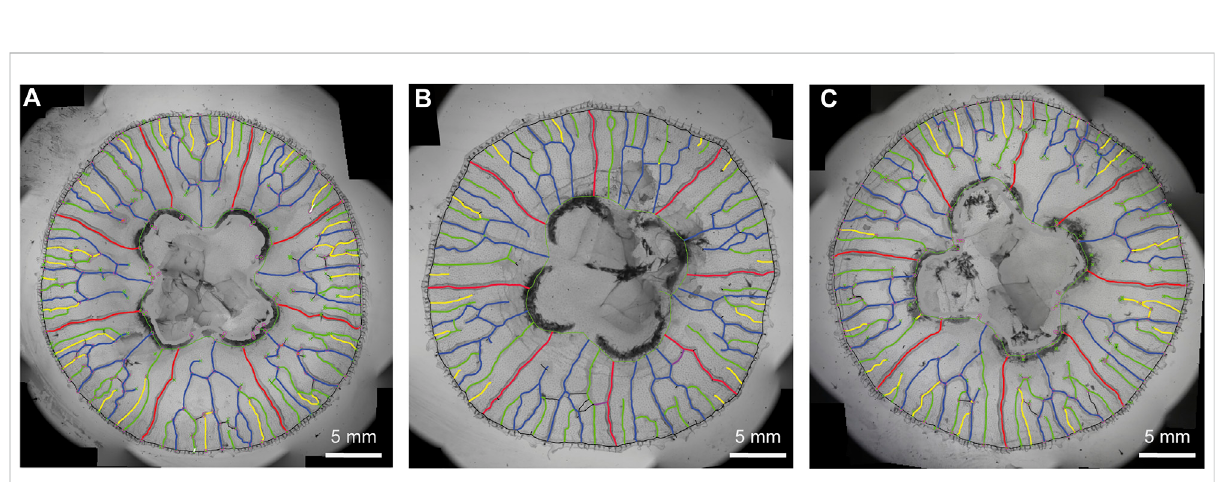
FIGURE 6 Threeclones from thesamepolyp. (A – C) Thepattern has been interpreted for easier comparison. AsinFigure 1B, theadradial canals aredrawn in red; the central canal, and the fi rst side canals forming the trifurcation are drawn in blue; the second generation in green; the third in yellow. One can observe many irregularities as in Figure 5: side canals not reconnecting to the central one, reaching (or going to reach) the stomach pouch, interconnections to straight canals [violet, in (B) ] and to other radial canals (black) making loops. All these irregularities, although similar in the three clones, are in detail